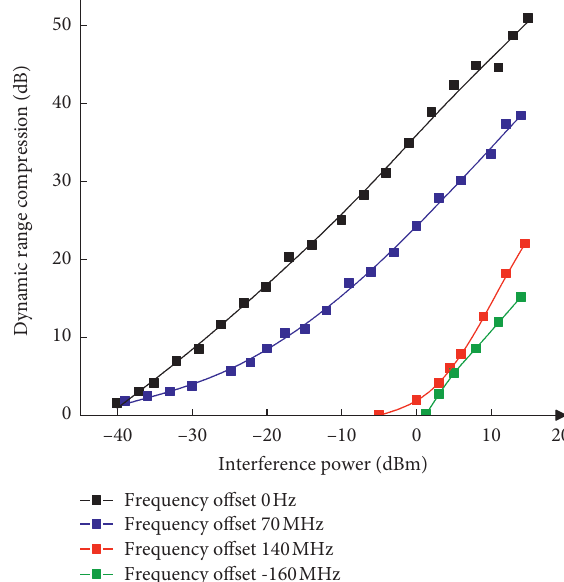
Figure 3: The dynamic range compression changes with the in- terference power under different frequency offsets.